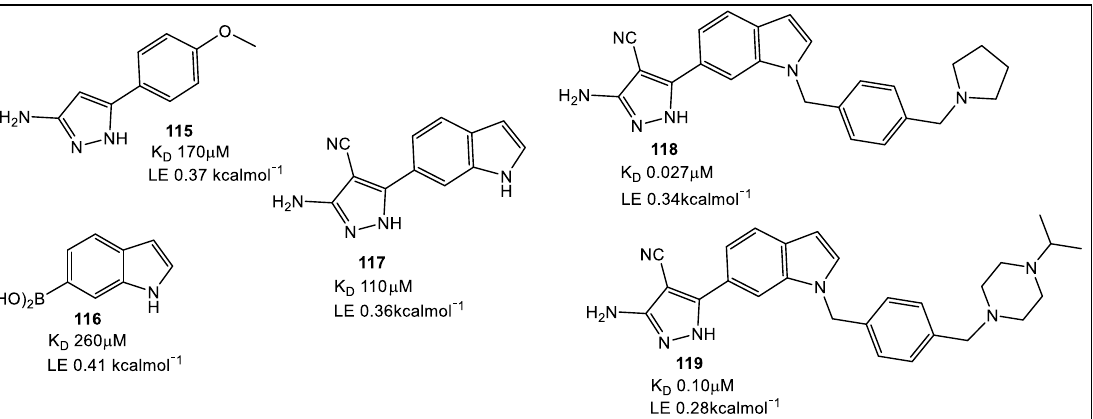
Figure 20. Fragment hits for MabTrmD. Elaboration on fragment 117 resulted in 118 (K D 27 nM, LE 0.34), a low-nanomolar affinity compound with anti-MabTrmD activity. Screening of merged fragments 115 and 116 (e.g., 118 ) against Mab and Mtb showed promising MIC values. Compound 119 had the best MIC values against Mtb and Mab of 1.6 μM and 2.3 μM in supplemented 7H9 medium [91]. This series of compounds had activity against mycobacteria in vitro and in vivo [97].